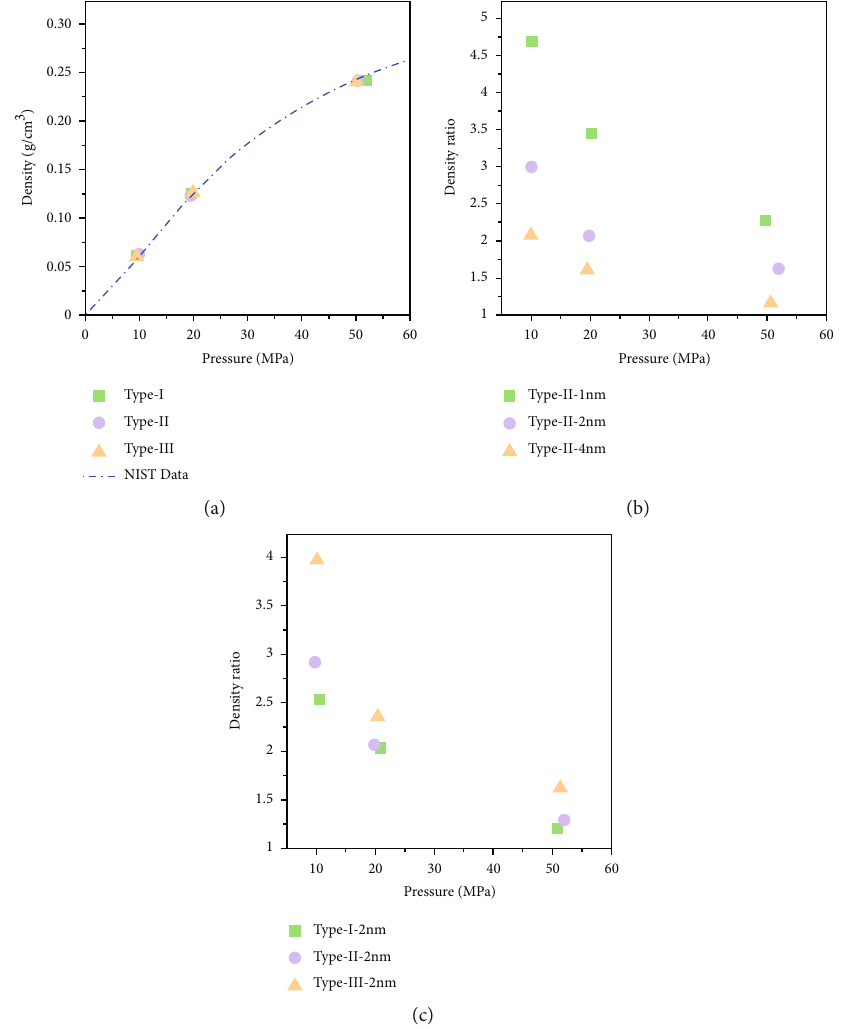
Figure 6: Comparison of CH density simulation results. (a) CH bulk density simulation results vs. NIST data, (b) density ratio vs. pressure 4 4 with the same kerogen type, and (c) density ratio vs. pressure with the same pore